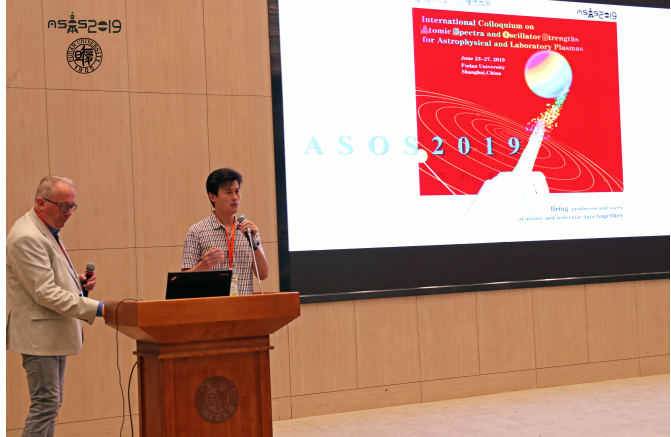
Figure 1. Prof. Tomas Brage ( left ) and Assoc. Prof. Jun Xiao giving the opening speech of